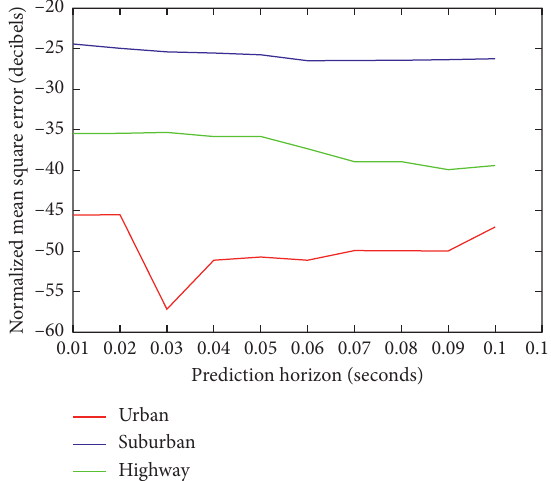
Figure 10: NMSE vs. prediction horizon for different urban, suburban, and highway environments with k � 32, L � 100, and Δ t �